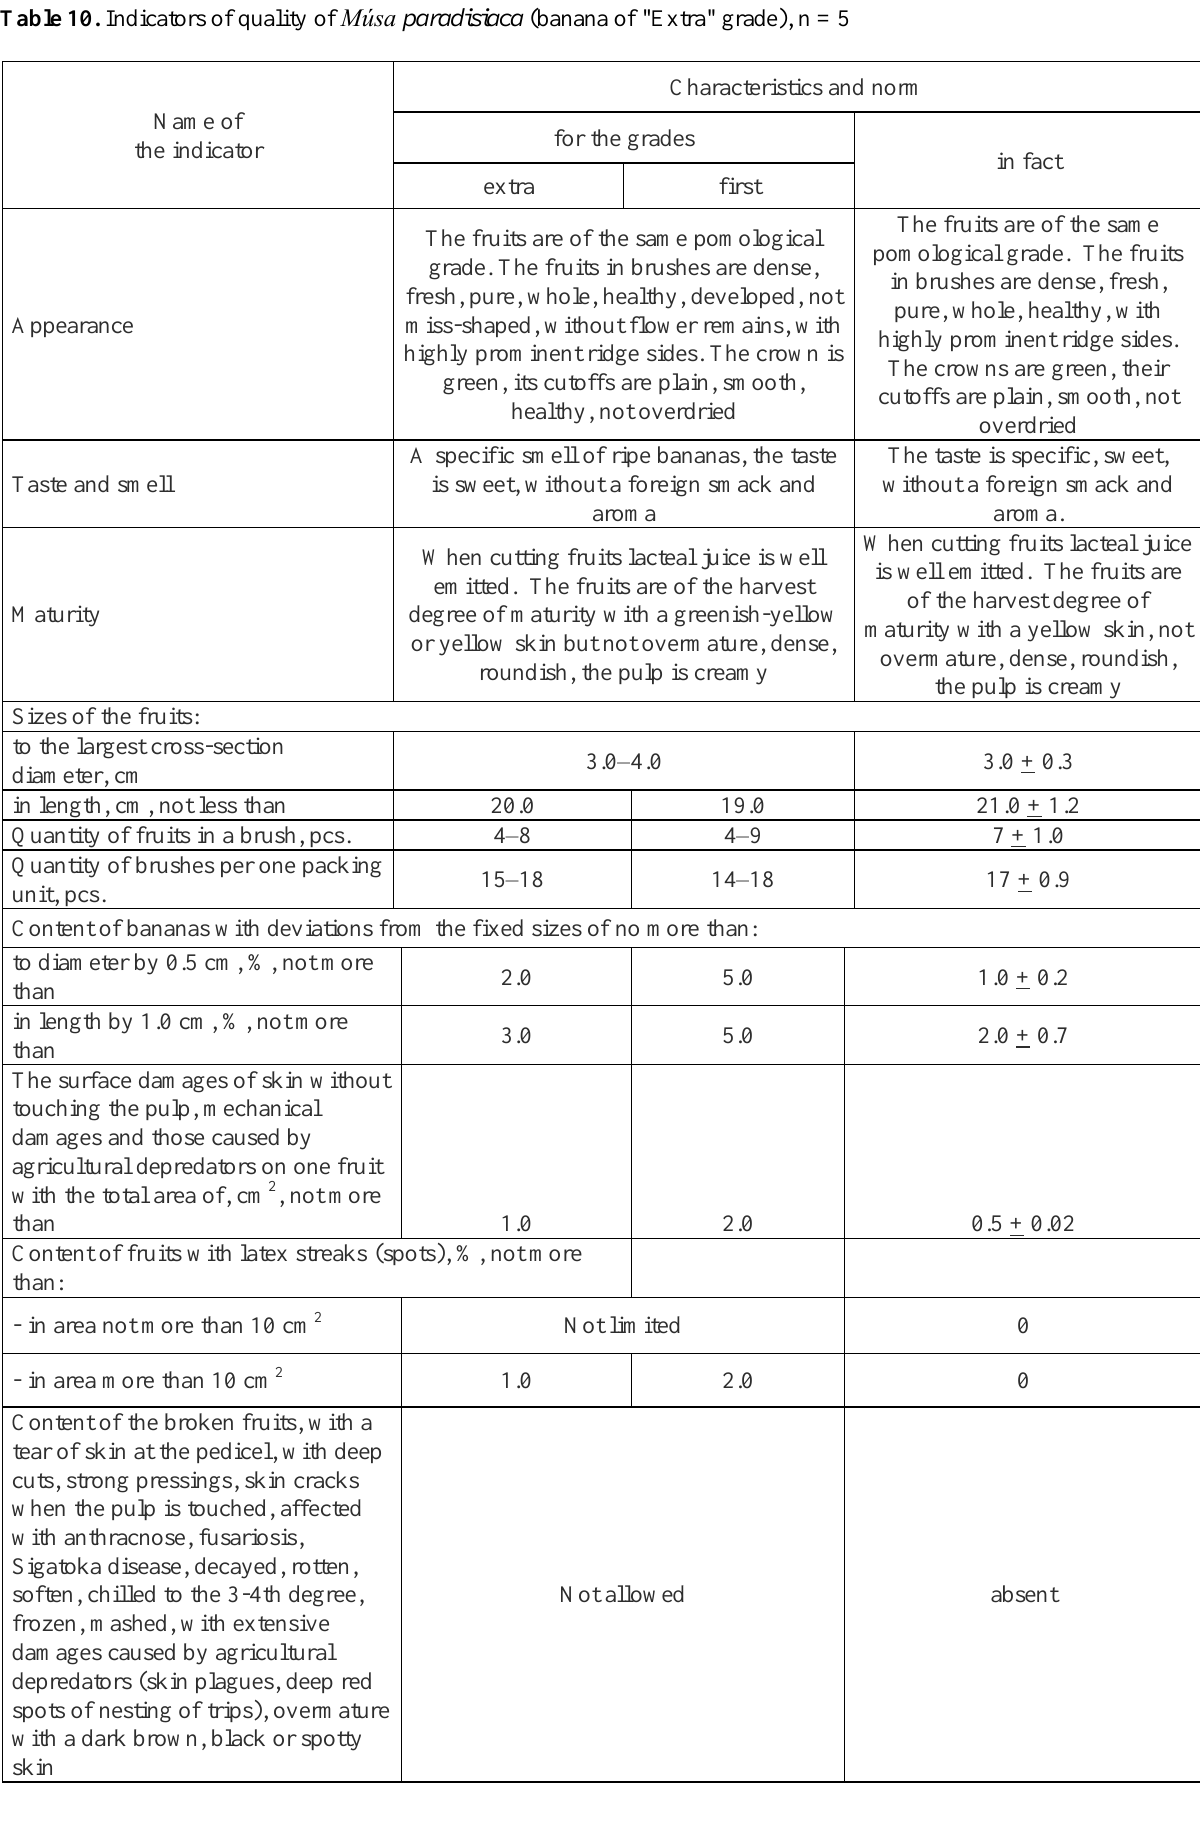
Table 10. Indicators of quality of Músa paradisiaca (banana of "Extra" grade), n =